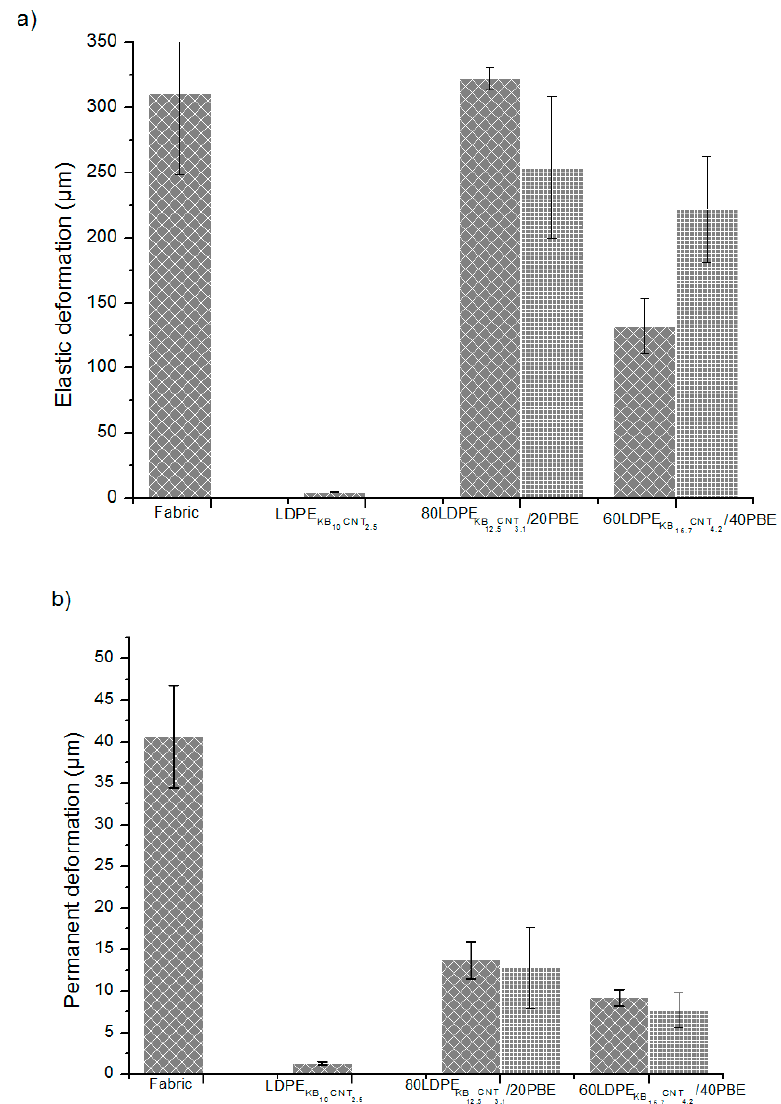
Figure 26. Elastic ( a ) and permanent ( b ) deformations ( µ m) of the 3D-PPOT materials made of conducting biphasic blends produced by a 1-step ( Figure 25. Strain (%) of the conducting biphasic blends produced by a 1-step ( ) or 2-step ( ) extrusion 3D-printed onto textile materials in the cross ( a ) and machine ( b ) directions of the fabric.